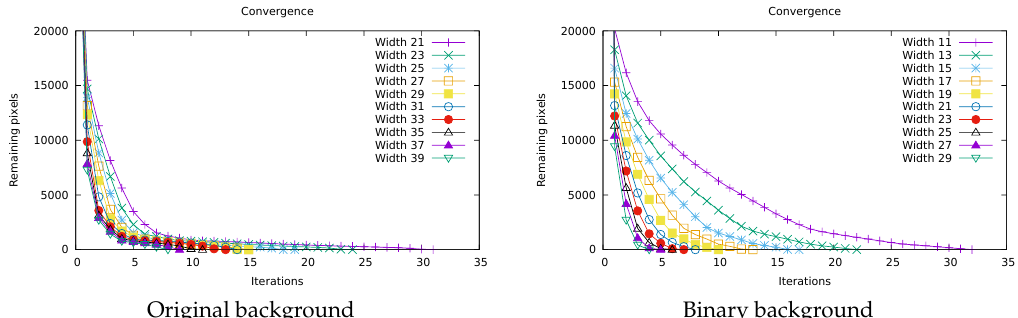
Figure 13. Number of iterations needed to remove the text for and historical map (Figure 11), with the original background ( left ) and after binarization ( right ), using different filter sizes.